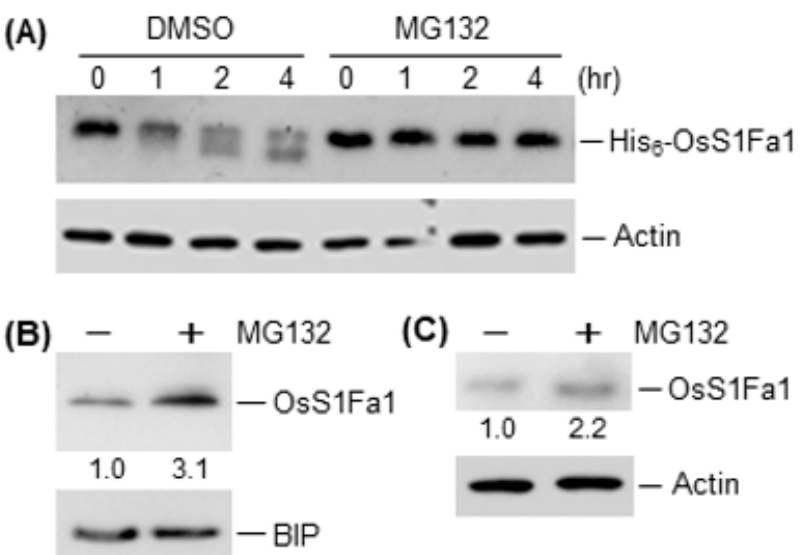
Figure 5. Effect of a proteasome inhibitor on the OsS1Fa1 protein level. ( A ) Cell-free degradation assay of OsS1Fa1. Rice leaf extracts were mixed with purified His 6 -OsS1Fa1 and treated with 50 µM MG132 (26S proteasome inhibitor) or 2% dimethyl sulfoxide (DMSO; solvent for the inhibitor; control) for the indicated time periods. OsS1Fa1 levels were determined by Western blotting using anti- OsS1Fa1 antibody, with known concentrations of actin serving as loading controls. ( B , C ) Proteasome pathway-mediated OsS1Fa1 degradation in vivo. Rice seedlings ( B ) and OsS1Fa1 -overexpressing Arabidopsis plants ( C ) were treated with 50 µM MG132. After overnight incubation, the OsS1Fa1 protein concentration was assessed by Western blotting using anti-OsS1Fa1 antibody, with known concentrations of actin or binding protein (BIP) serving as loading controls. Values below each lane indicate relative intensities. All experiments were repeated three times, with similar results.